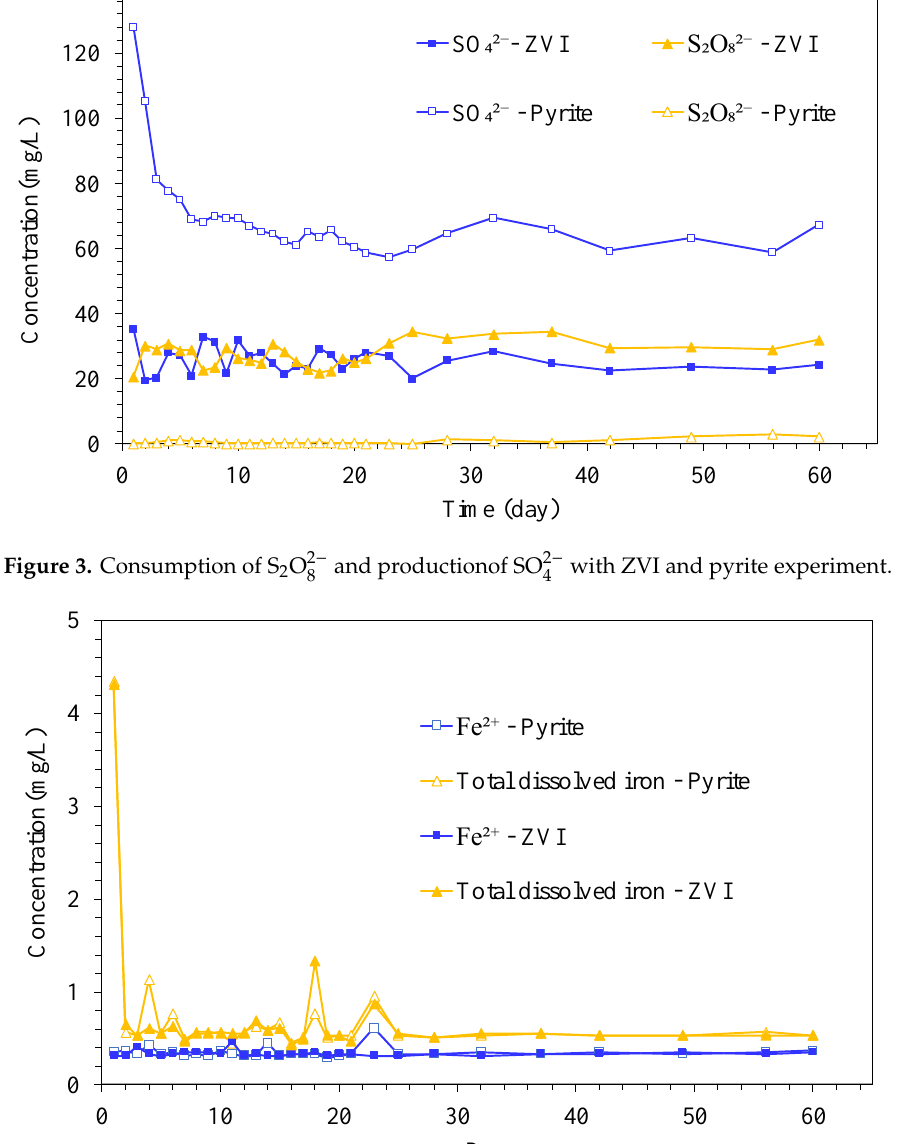
Figure 4. Release of total dissolved iron and Fe²⁺ concentration.